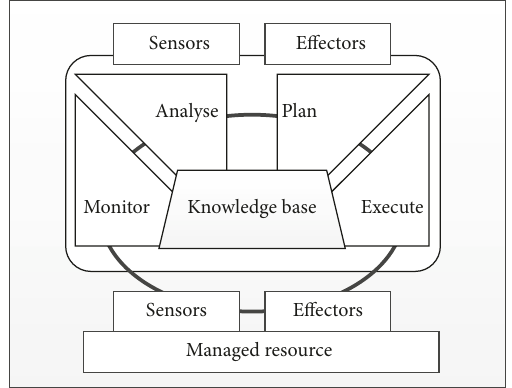
Figure 1: MAPE autonomic computing model